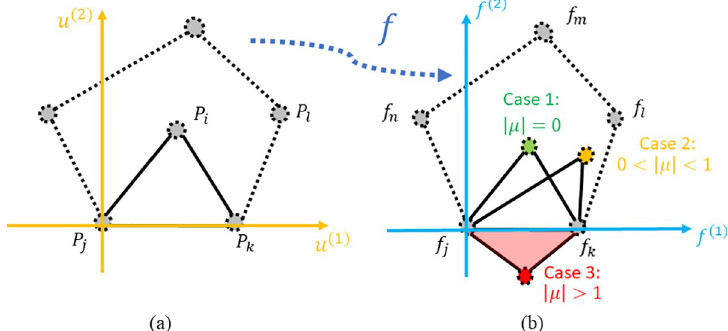
Fig 2. Beltrami coefficient and topological condition: (A) source triangle (triangle Δ P Δ f i f j f k from three different types of mappings, with different Beltrami